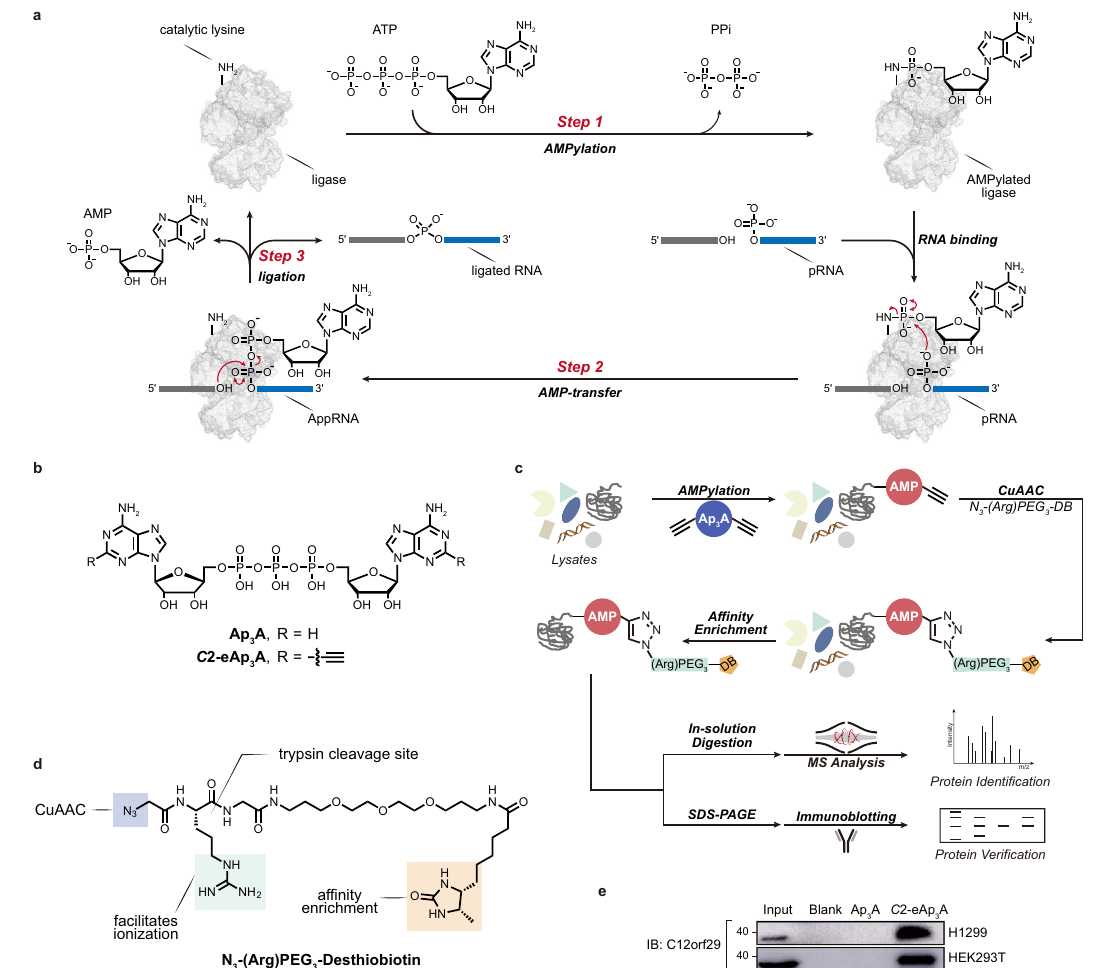
Fig. 1 | RNA ligase mechanism and identi fi cation of C12orf29 by chemical pro- teomics using modi fi ed Ap 3 A probe. a Schematic display of the three-step mechanism of RNA ligation by a 5 ′– 3 ′ RNA ligase. In step 1, the ligase is auto- AMPylatedonthecatalyticlysineusingATPastheco-substrate.Instep2,theAMPis transferred from the catalytic lysine to the 5 ′ -PO 4 end of RNA (pRNA), giving the RNA-adenylateintermediate(AppRNA).Instep3,theligatedRNAisobtainedupon the attack of 3 ′ -OH to the AppRNA in the presence of the ligase along with the liberationofAMP.PPi,pyrophosphate. b StructuresofAp 3 Aanaloguesemployedin